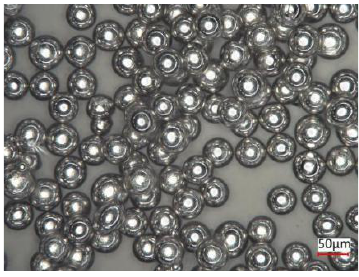
Figure 11. Microscopic image of Inconel718 alloy powder.